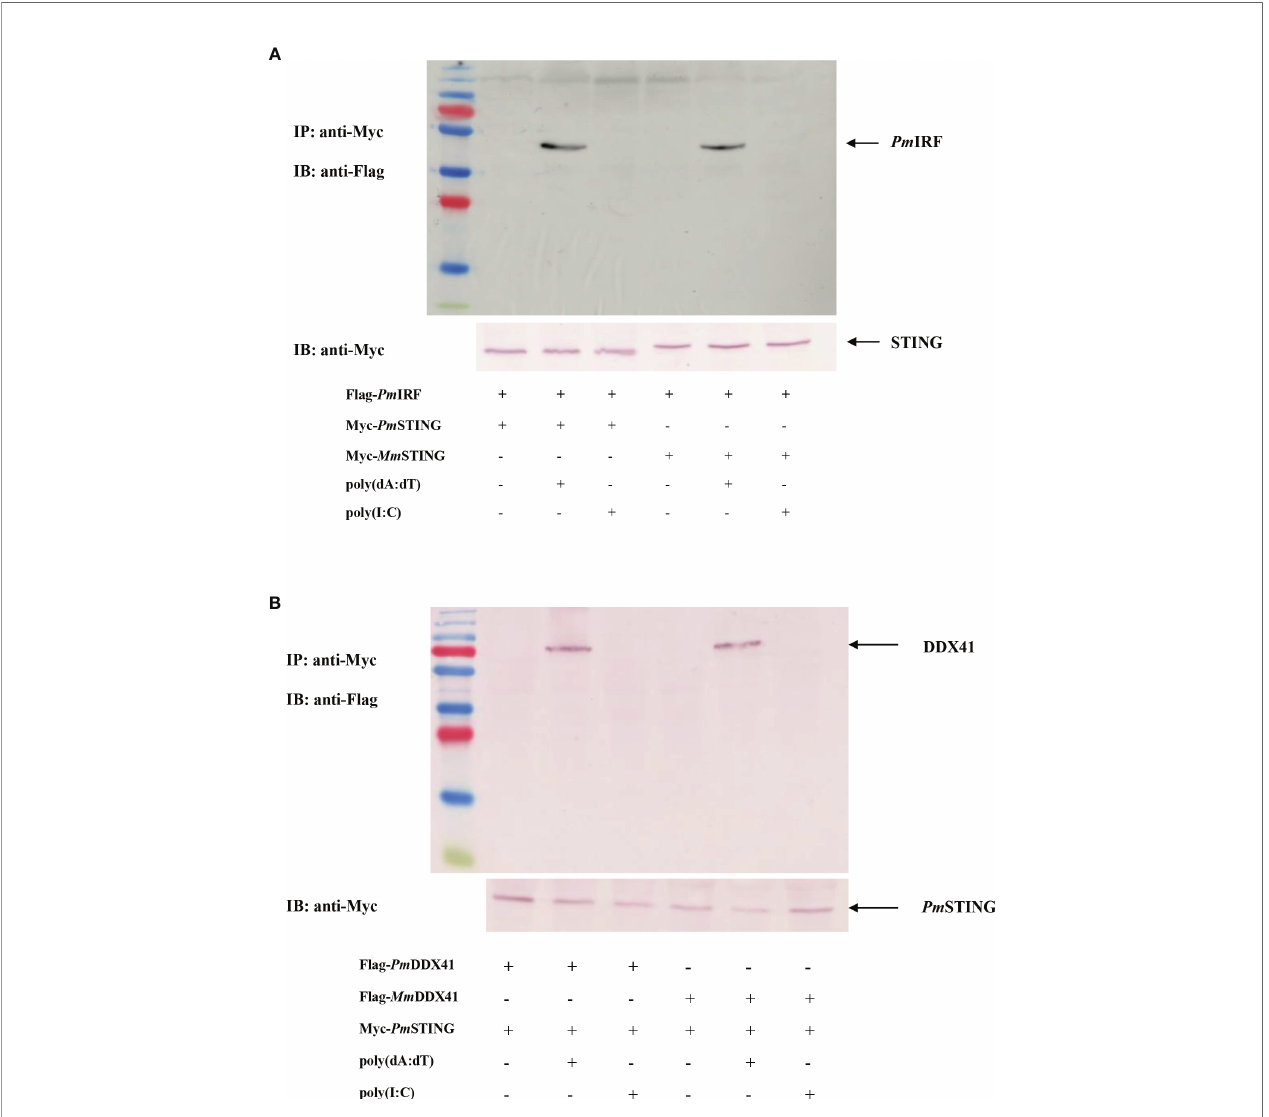
FIGURE 4 | Co-immunoprecipitation of P. monodon proteins in HEK293T cells. (A, B) Cells were co-transfected with Flag-tagged full-length Pm IRF (A) or Pm DDX41 (B) plasmid, and 24 h later the co-immunoprecipitation of the P. monodon proteins with Myc-tagged Pm STING was detected following stimulation with poly(dA:dT) or HMW poly (I:C) for 6 h using HRP-conjugated anti-Flag and -Myc antibodies; the mouse homologs Mm STING [in panel (A) ] and Mm DDX41 [in panel (B) ] were used as